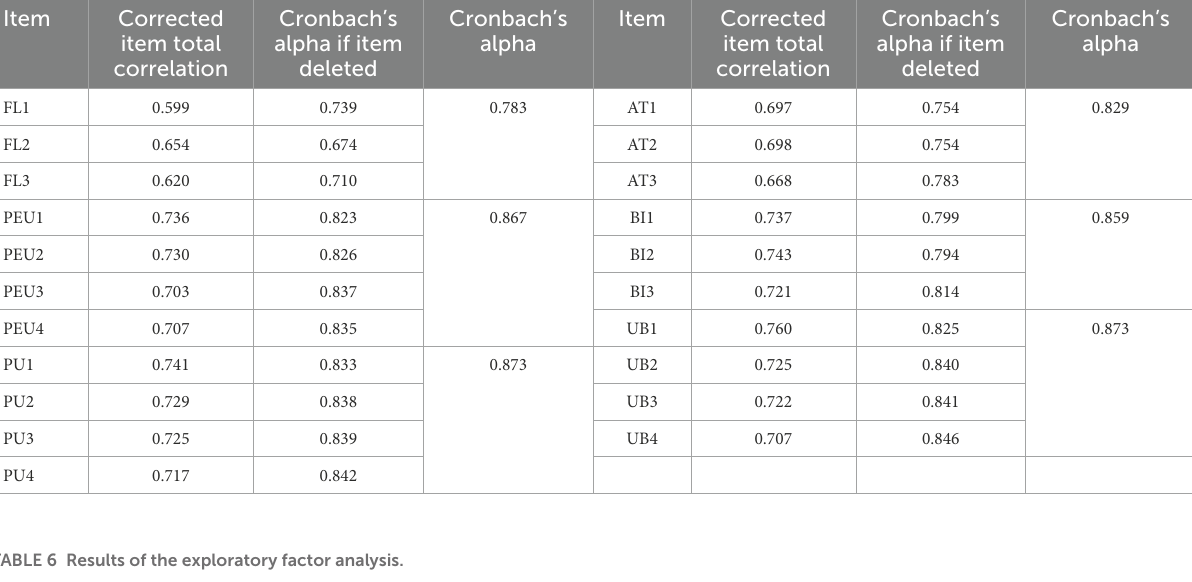
TABLE 5 Analyses of reliability.